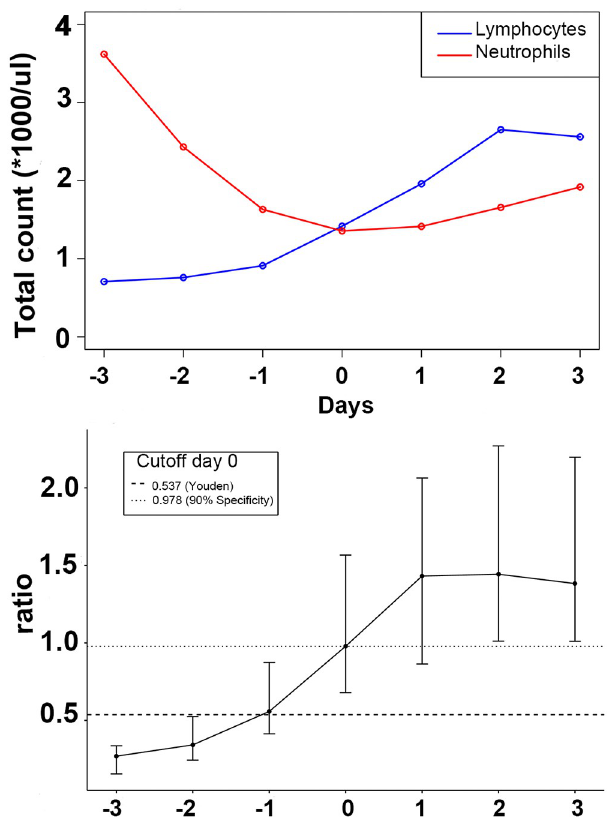
Fig 4. Evolution of neutrophils and lymphocytes absolute counts and their ratio. A. Evolution of the neutrophils and lymphocytes absolute counts’ medians for dengue patients. B. Evolution of the neutrophils over lymphocytes ratio and selected cutoffs (method used) to differentiate between D0 and any previous day. The intervals represent the range between the first and the third quartiles. (- - -) sensitivity = 0.80, specificity = 0.65; ( ����� ) sensitivity = 0.47, specificity =